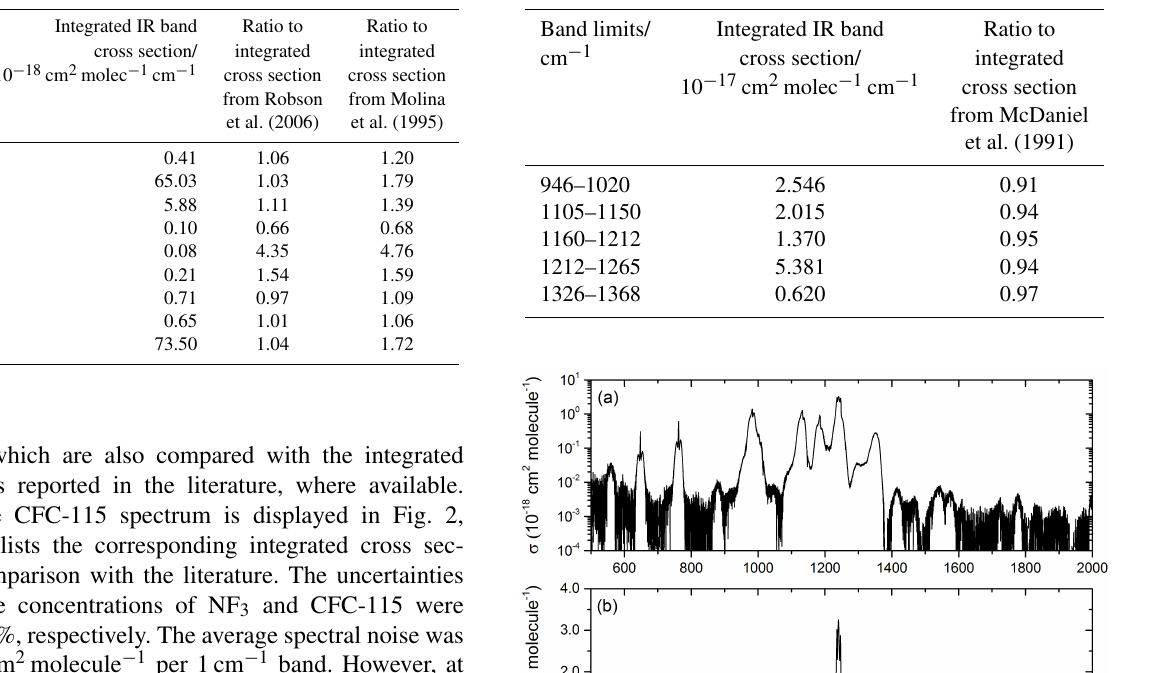
Table 2. Integrated absorption cross sections of NF 3 measured in the present study at 296 ± 2K (1 σ uncertainty ± 6% for the major bands), and compared to the previous studies of Robson et al. (2006) and Molina et al. (1995).